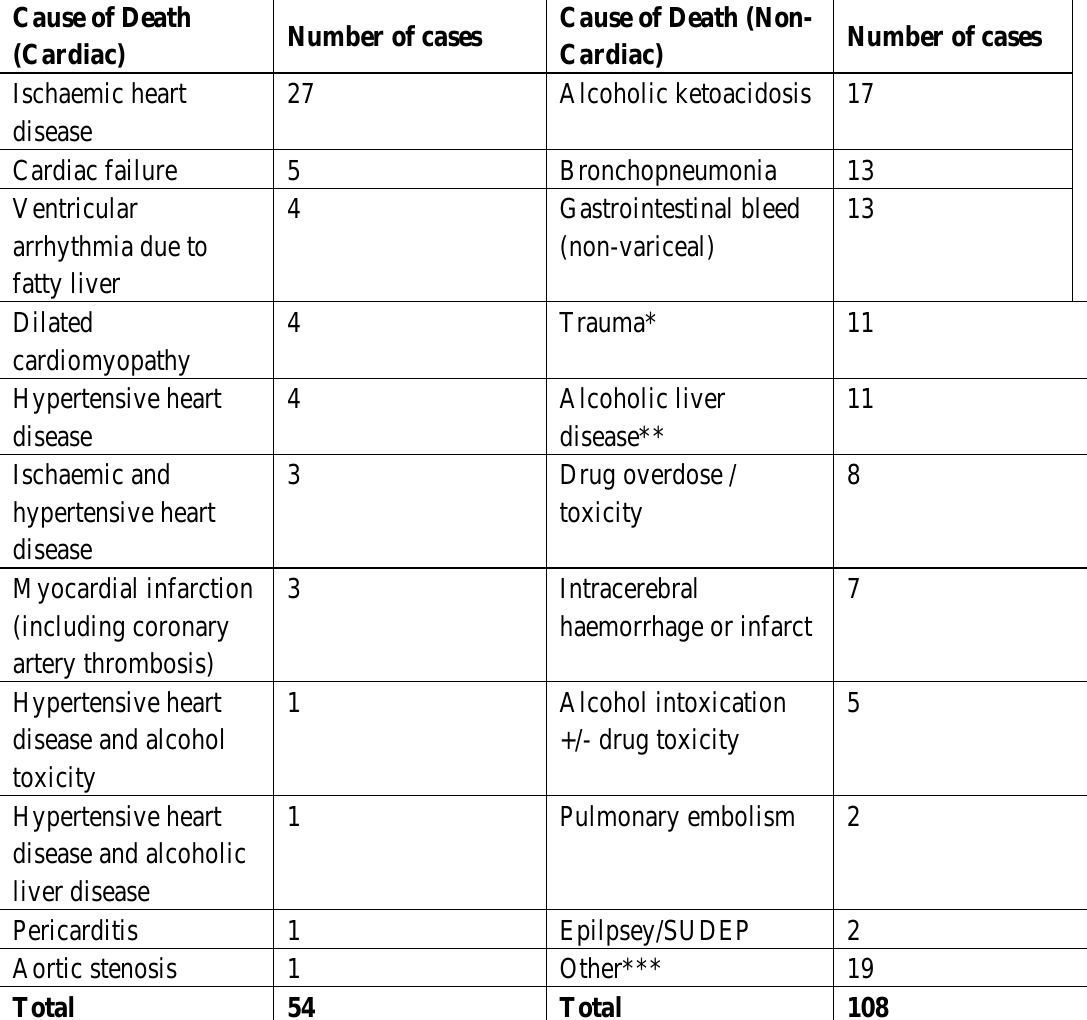
Table 1. A breakdown of causes of death for the “alcohol excess” group (n = 162) divided into cardiac and non cardiac